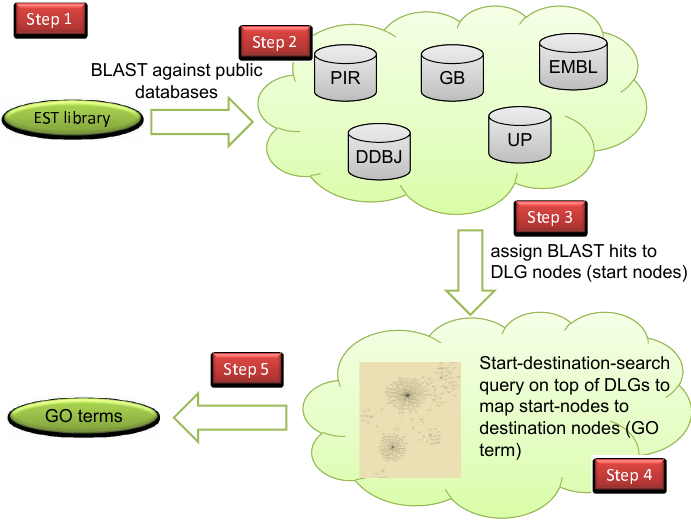
Figure 2: work flow to assign ESTs to GO